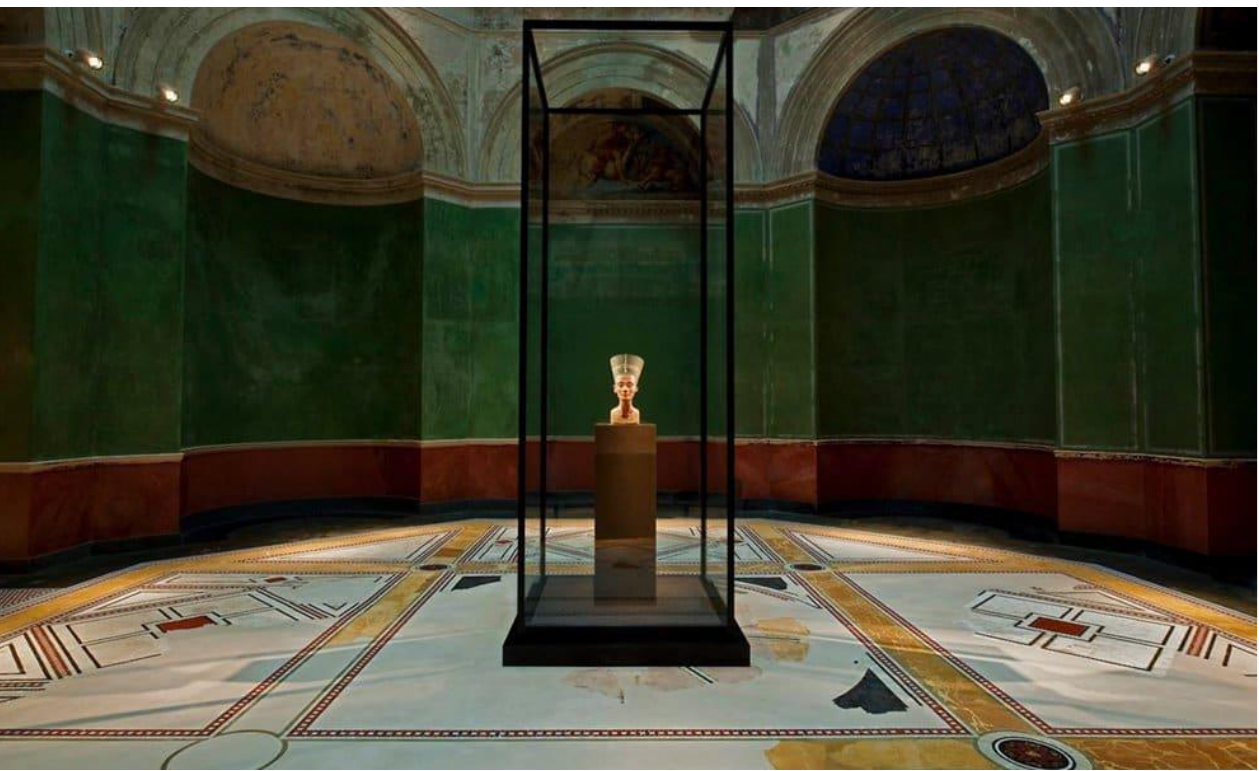
Figure 6. Nefertiti bust, Neues Museum, Berlin. Photo in public domain.